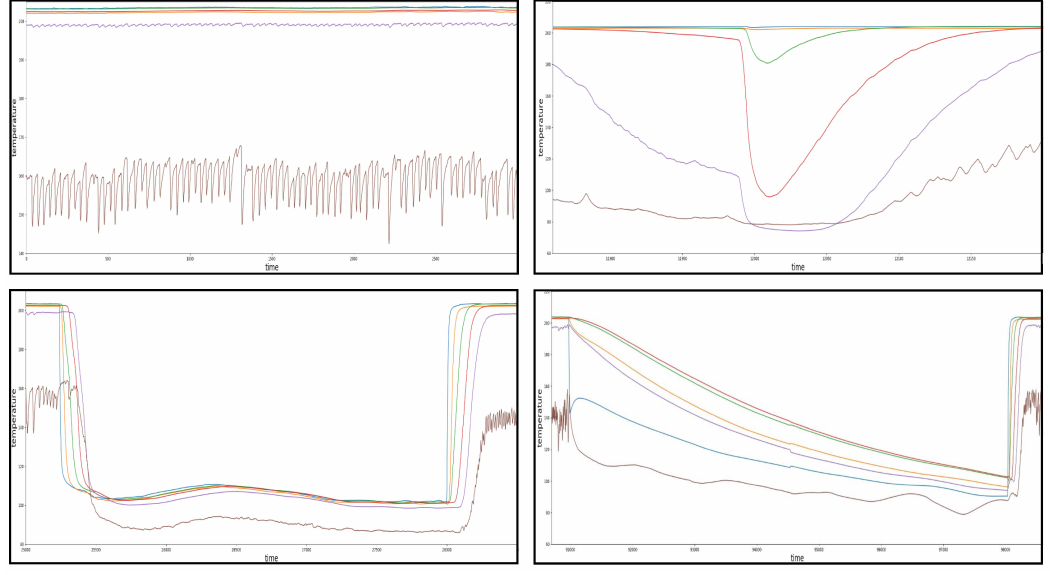
Figure 13. Graphical depiction of most frequent